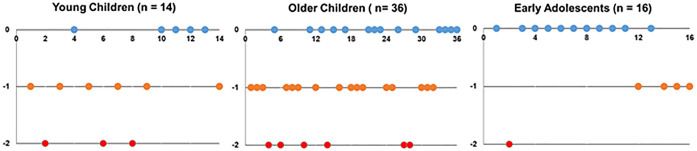
Matching of categories by axial elongation and changes in myopia in the three different age groups.Matching pairs are indicated by ‘0’. Progression rate was under-estimated either by 1 category (indicated by ‘-1’) (i.e. ‘Rapid’ to ‘Moderate’ or ‘Moderate’ to ‘Slow’), or 2 categories (indicated by ‘-2’) (i.e. ‘Rapid’ to ‘Slow’).